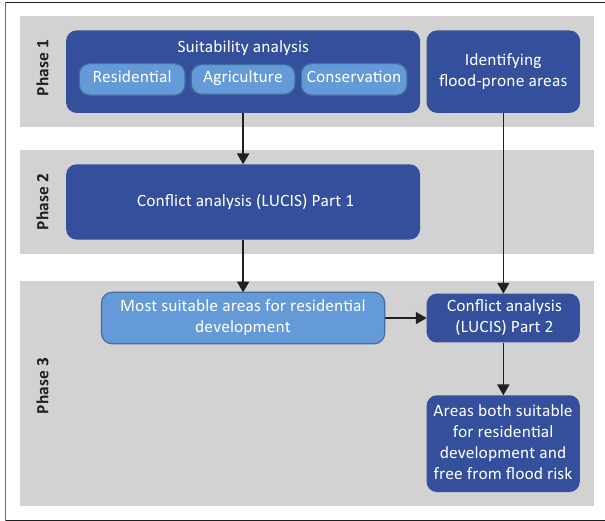
FIGURE 2: Analysis process. LUCIS, land use conflict identification